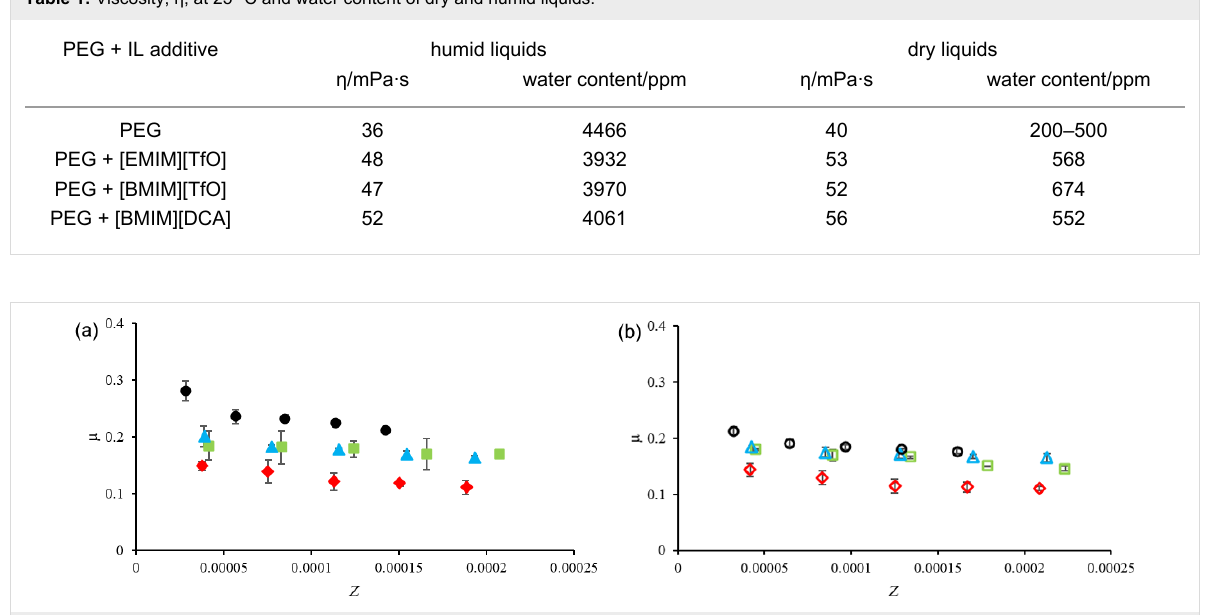
Figure 3: CoF as a function of the Sommerfeld parameter, Z , for (a) humid and (b) dry PEG (black circle) and PEG + [EMIM][TfO] (blue triangle), PEG + [BMIM][TfO] (red diamond), and PEG + [BMIM][DCA] (green square).